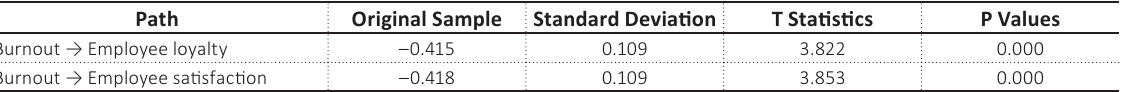
Table 3. Bootstrap results for indirect